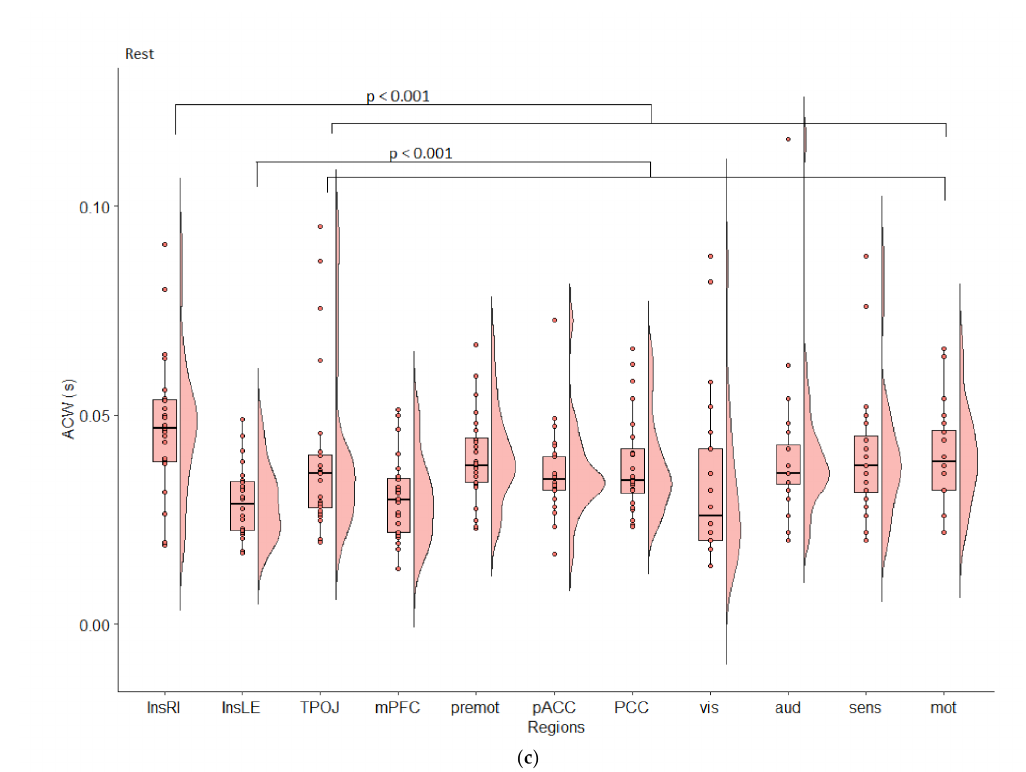
Figure 3. Autocorrelation calculated on the estimated activity per region in resting state. ( a ) Morphing task. Depicted is a schematic representation of the first condition ‘self to other’. Identity and order of faces vary depending on condition; ( b ) Longer ACW were found in the right Insula compared to the left insula; ( c ) The insula in comparison to primary sensory and motor regions as well as the regions implicated in the three layers model of the self. p -values are Bonferroni- corrected post hocs. Aud = primary auditory cortex, InsLE = left Insula, InsRI = right Insula, mot = primary motor cortex, mPFC = medial prefrontal cortex, pACC = perigenual anterior cingulate cortex, PCC = posterior cingulate cortex, premot = premotor cortex, sens = primary somatosensory cortex, TPOJ = temporo-parieto-occipital junction, vis = primary visual